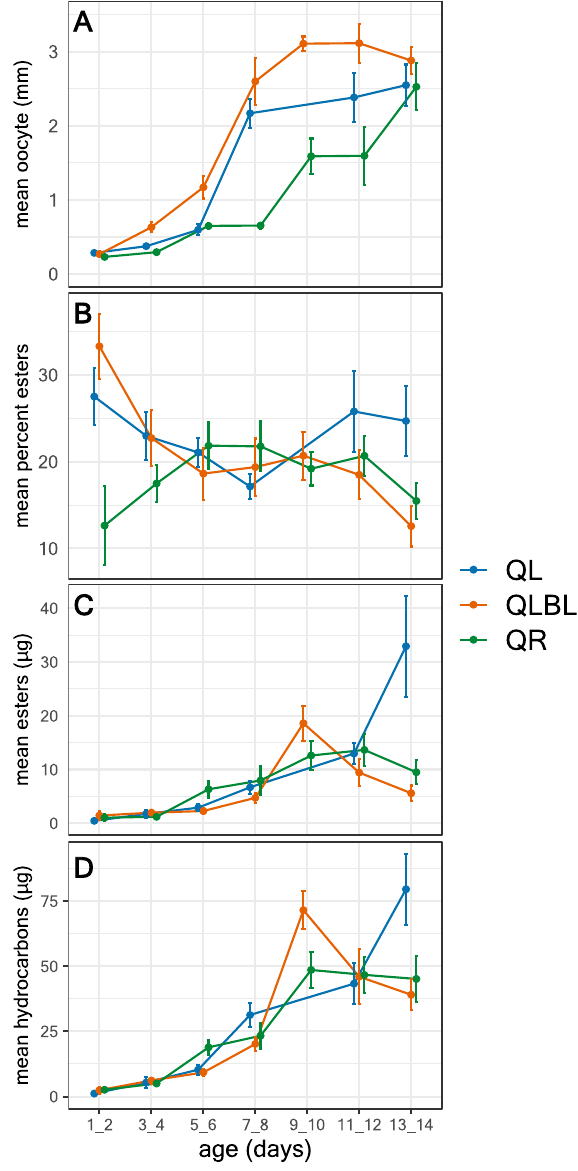
Figure 2. Change in worker reproductive state and Dufour’s gland chemistry as a function of age (1–14 days post emergence) and social condition: queenright (QR), queenless (QL), and queenless, brood-less (QLBL) workers. ( A ) mean terminal oocyte size (mm), ( B ) mean percent of total esters, ( C ) mean µg of total esters, and ( D ) mean µg of total hydrocarbons. Data are grouped into two-day bins and represent the mean value of 10 workers per age group ±